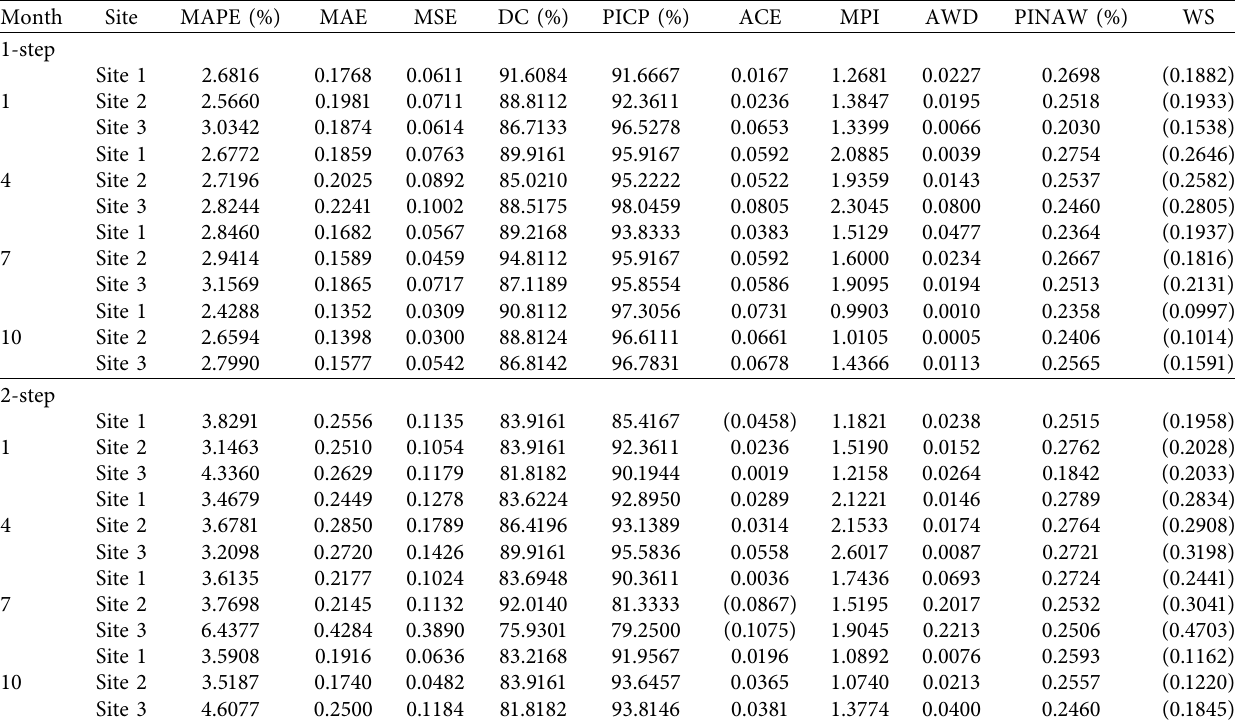
Table 14: Performance of proposed model in different seasons.